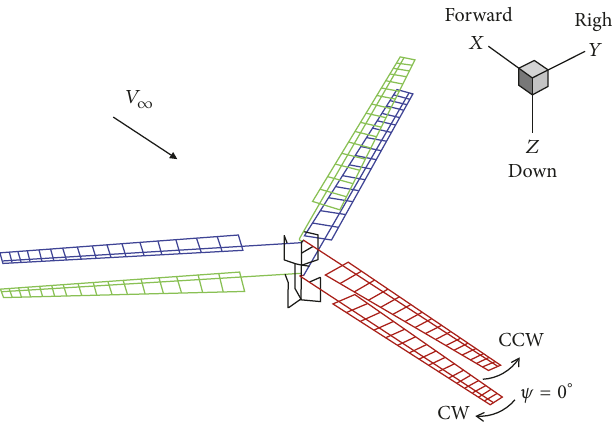
Figure 4: CAMRAD II model of XH-59A rotor.